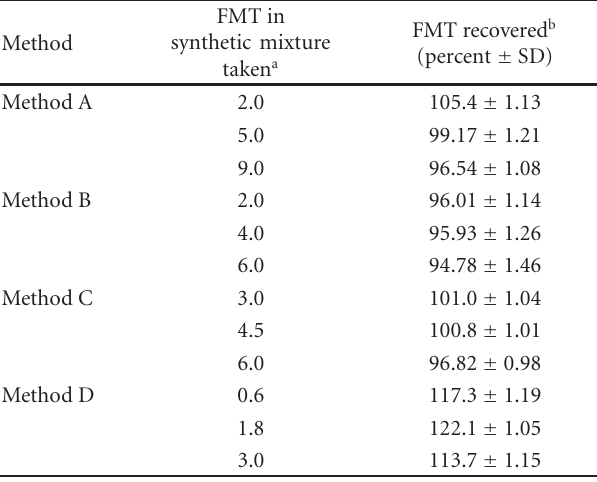
Table 4: Recovery of the drug from synthetic